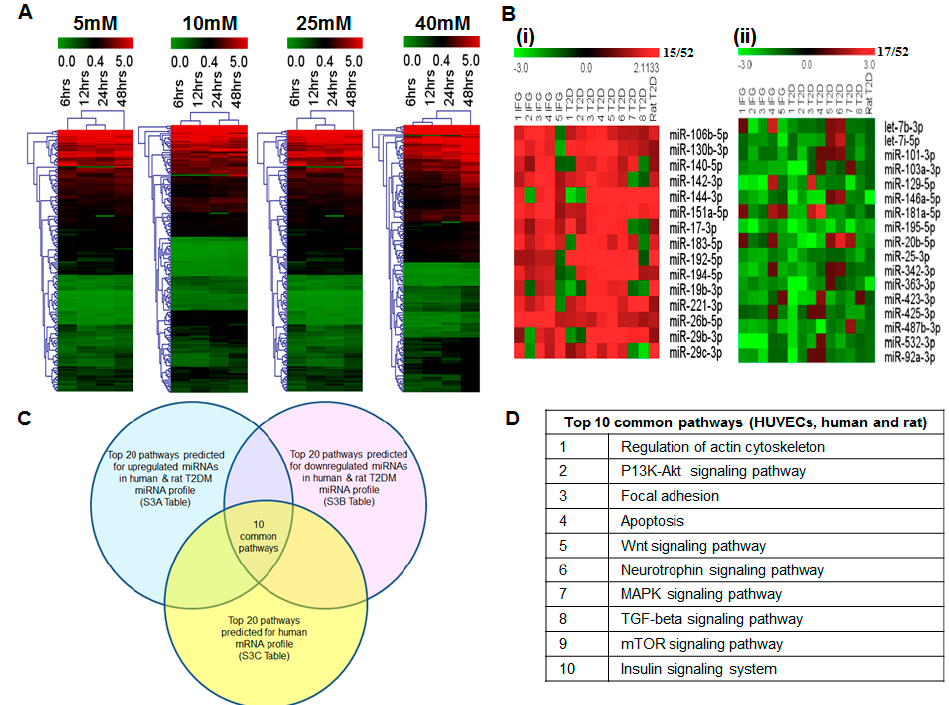
Figure 3. miRNA microarray and pathway analysis. ( A ) Hierarchical clustering of miRNAs in HUVECs subjected to different glucose treatments (5, 10, 25, and 40 mM) at 6, 12, 24 and 48 h. In total, 177 miRNAs with background subtracted mean signal intensities ≥ 300 are included; ( B ) Heat map of selected 52 miRNAs dysregulated in human and rat. miRNAs that showed differential expression are grouped into two categories ( i , ii ) of miRNAs that remained ( i ) upregulated in both impaired fasting glucose (IFG) and T2DM ( ii ) downregulated in both IFG and T2DM vs. controls. Data are expressed as fold change. Red represents up-regulation; green indicates down-regulation and grey indicates not detected; ( C ) Venn diagram showing results of pathway analysis for dysregulated miRNAs and mRNAs using DIANA miRPath 2.0 and WebGestalt, respectively; ( D ) Ten common pathways that could possibly participate in endothelial dysfunction are also shown.